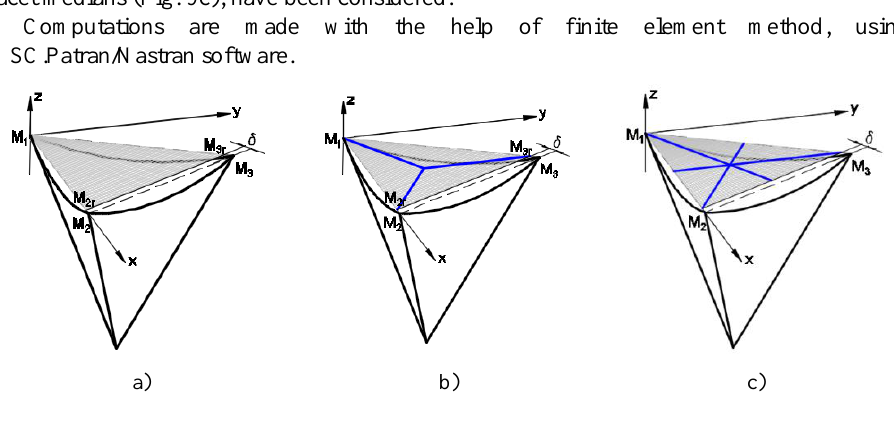
Fig. 9. Variants of SGS implementation.